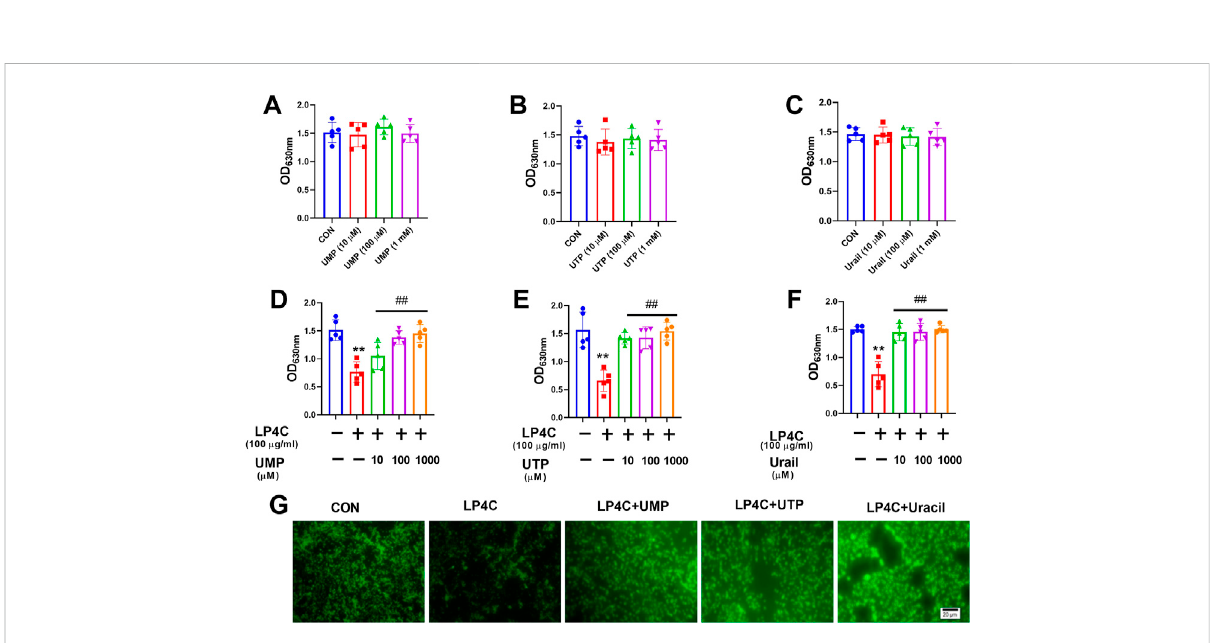
FIGURE 5 Pyrimidine restores LP4C impaired bio fi lm formation ability of MRSA. The bio fi lm formation of MRSA USA300 was observed after supplementation of UMP (A) , UTP (B) or uracil (C) by crystal violet staining. The UMP (D) , UTP (E) or uracil (F) restored the impaired bio fi lm formation ofMRSAUSA300aftertheLP4Ctreatment,** p < 0.01vs . untreatedcontrolgroup, ## p < 0.01vs . LP4Ctreatedgroup,n=5.TheeffectofUMP,UTPor uracil supplementation to the adherence capability of MRSA USA300 after LP4C treatment (G)